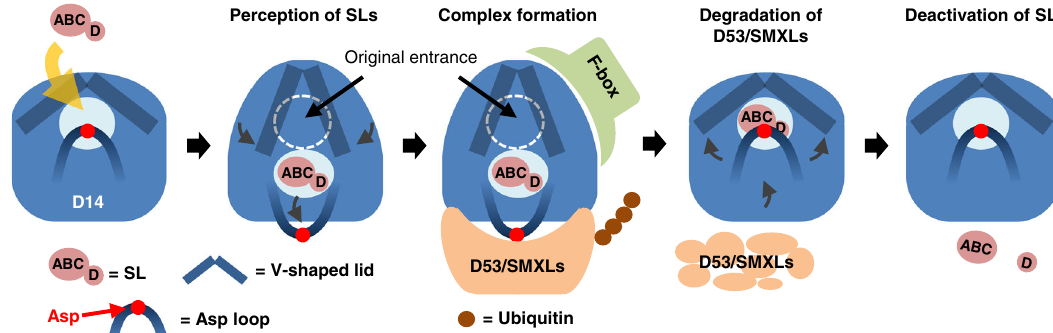
Fig. 5 A proposed working model of D14 in the SL signaling pathway. A bioactive SL molecule induces the protein conformational changes of D14, which triggers complex formation with the signaling partners. After the degradation of D53/SMXLs and transmission of the SL signal, D14 reconstructs the catalytic triad to hydrolytically decompose the bioactive SL both chemicals. After 4h (for GR24) or 6 h (for CN-PMF) incubation at 30°C, the reaction was terminated and 15 μ L and 25 μ L of each sample were used for DSF experiments and hydrolysis analysis, respectively. For DSF experiments, 5 μ L of Sypro Orange solution, diluted 333X with PBS, was added to each sample. DSF experiments were performed as described above. For hydrolysis assays, the reaction was stopped by adding 25 μ L of acetonitrile. For GR24 type ABC-FTL, d 1 -GR24 type ABC-FTL was used as an internal standard. For HMB, HBN, and CN-PMF, 1- naphtaleneacetic acid (NAA) was used as an internal standard. The detailed ana- lysis condition for each chemical is described in Supplementary Table 3. Analysis of the AtD14 protein modi fi cation during hydrolysis . MBP-AtD14 (24 μ g) was incubated in 45 μ L of PBS (pH 7.4) containing a chemical (GR24 (40 μ M),